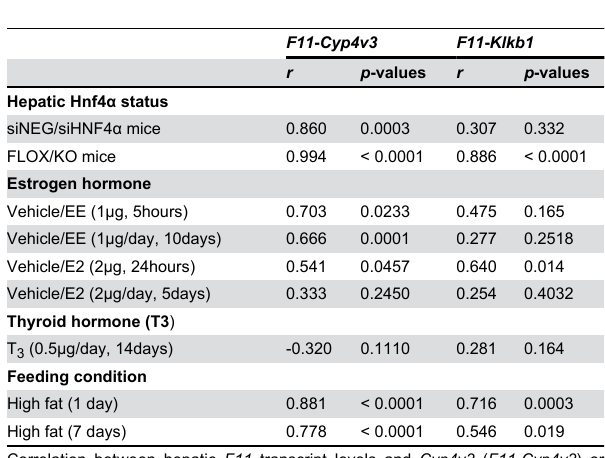
Table 3. Transcript levels of F2, F7, F10 and F12 in livers of challenged